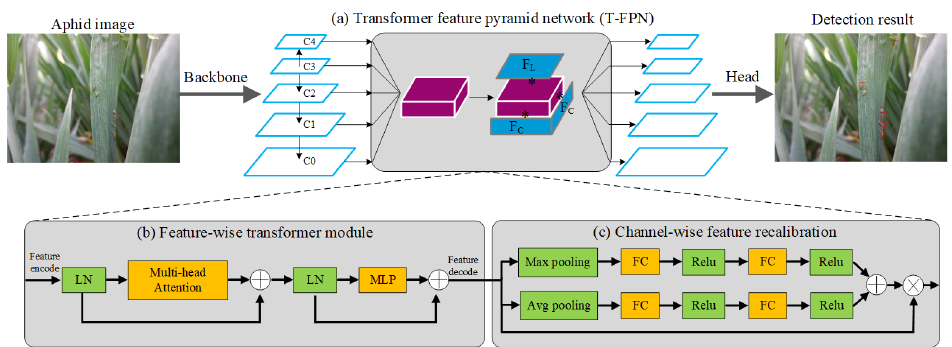
Figure 2. The network architecture of TD-Det with T-FPN, where LN is layer normalization, MLP is multi-layer perceptron, FC is fully connected, ReLu is rectified linear activation function, and C0–C4 are feature